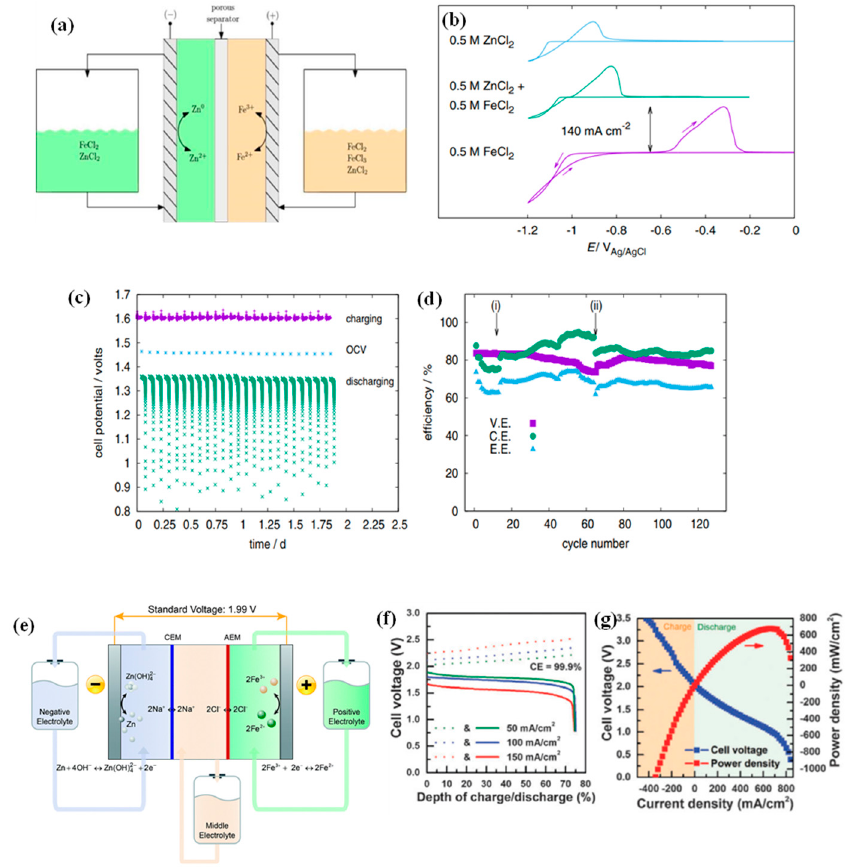
Figure 15. ( a ) Schematic of an acidic ZIRFB with mixed electrolytes; ( b ) CV curves for three Zn/Fe ratios (titanium substrate, pH = 1); ( c ) cell potential change during testing time; ( d ) VE, CE, and EE changes during continuous charge–discharge cycling (T = 25 °C). Reproduced under terms of the CC-BY license [54]. Copyright 2017, IOP Publishing. ( e ) Schematic of the acid-base mixed ZIRFB; ( f ) Charge–discharge tests (SOC = 75%). The dash lines and solid lines represent the charging process and the discharging process, respectively; ( g ) cell polarization curves (SOC = 70%). Reproduced under terms of the CC-BY license [55]. Copyright 2015, Royal Society of Chemistry (RSC Publishing).